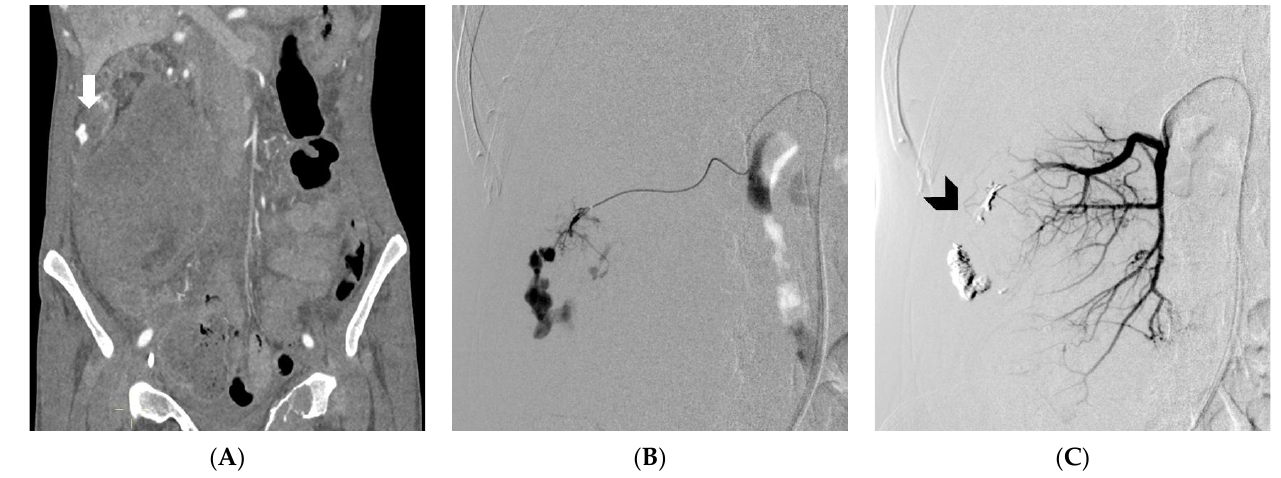
Figure 3. CT angiography of spontaneous retroperitoneal bleeding due to ruptured renal tumor pseudoaneurysm (arrow) ( A ). Digital subtraction angiography confirming ruptured pseudoaneurysm arising from a tumor feeding artery ( B ). Digital subtraction angiography showing effective embolization with EVOH copolymer cast (arrowhead) ( C ).